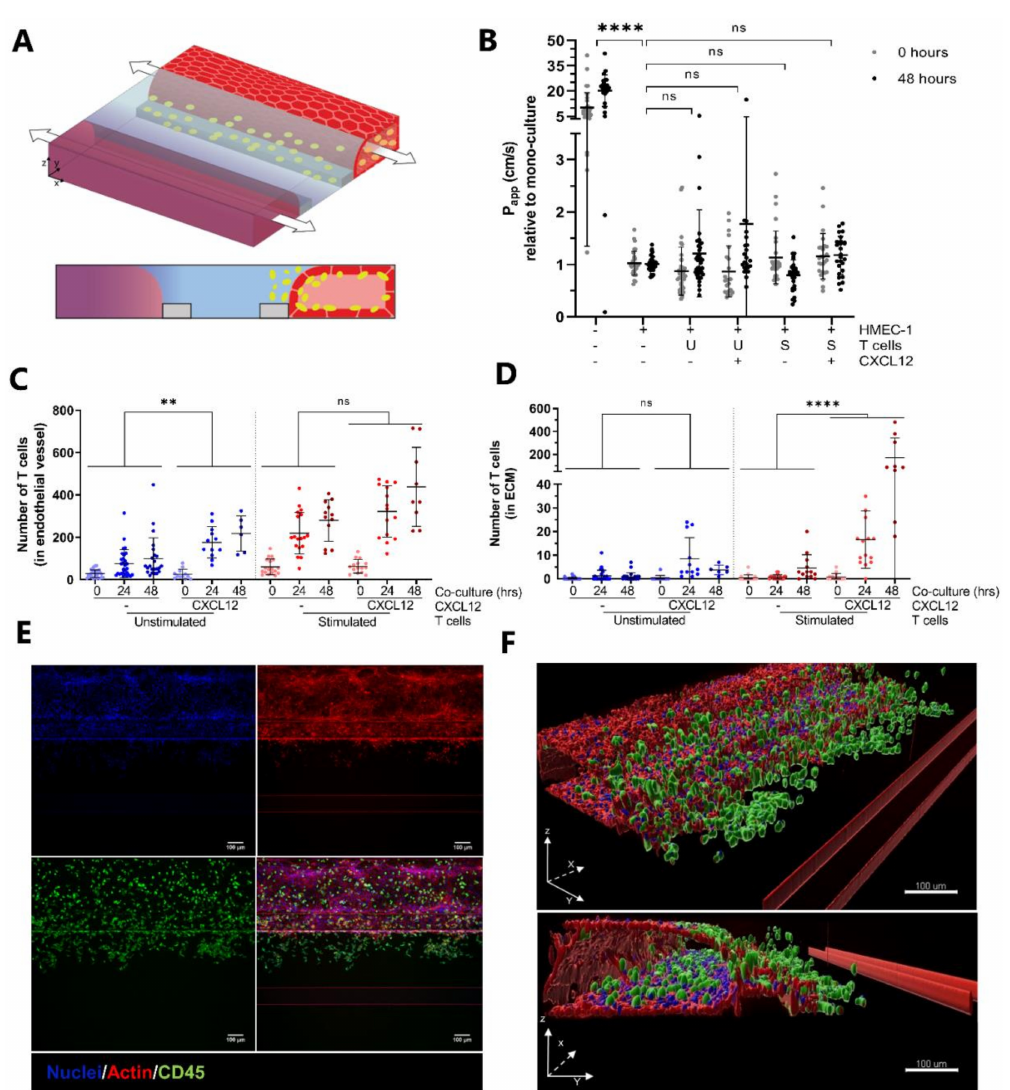
Figure 3. Addition of the chemokine CXCL12 increases T cell migration. ( A ) A chemotactic gradient is formed upon perfusion of the bottom channel with medium containing CXCL12 (purple hue). ( B ) Barrier integrity of HMEC-1 vessels is not affected by co-culture with either unstimulated or stimulated T cells in the presence or absence of CXC12. Apparent permeability (Papp) values are normalized against Papp values of mono-cultured HMEC-1 vessels. Shown are mean ± SD, and data points represent individual chips ( N = 7–13, n = 2–5). Statistical analysis was performed on non-normalized data. Data were log transformed and analyzed using mixed-effects models. Statistical analyses indicated significant differences between chips containing HMEC-1 vessels and empty chips (**** p < 0.0001), and no significant (ns) differences between mono-cultured and co-cultured vessels with or without CXCL12. ( C ) Quantification of T cell numbers in the endothelial vessel after 0, 24 and 48 h of co-culture. Shown are mean ± SD, and data points represent individual chips ( N = 2–7, n = 3–8). Data were log transformed and analyzed using mixed-effects models showing a significant effect of CXCL12 on the number of unstimulated T cells (** p = 0.0026; ns = not significant) residing in the vessel. ( D ) Quantification of T cell numbers in the ECM compartment after 0, 24 and 48 h of co-culture. Shown are mean ± SD, and data points represent individual chips ( N = 2–7, n = 3–8). Data were